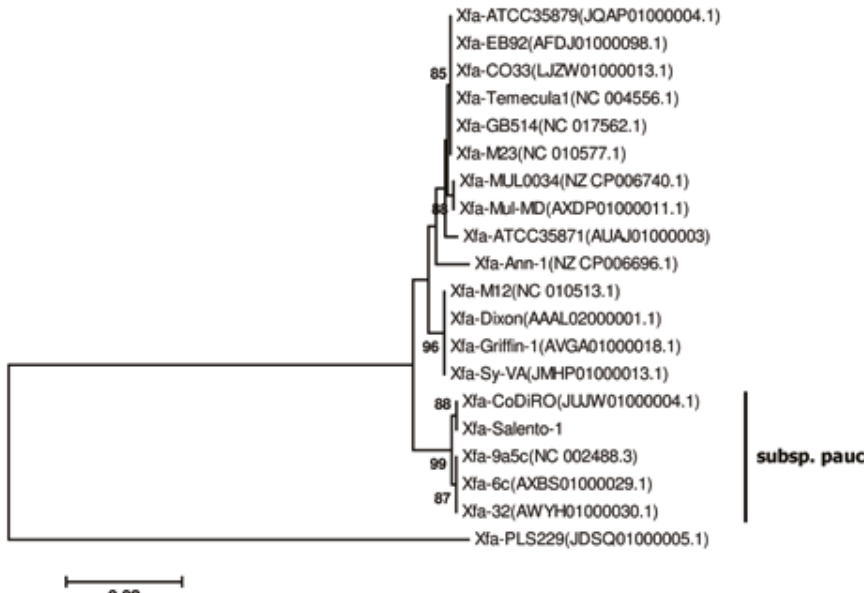
Figure 5. Neighbour joining dendrogram showing the similarity of 20 strains of Xylella fastidiosa based on rpoD partial sequence analysis (1308 nucleotides). Numbers above or below branches are bootstrap values based on 1000 pseudorepli- cates (only values above 80% are shown) under the Kimura 2 parameters model of evolution with gamma rate of variation across sites. The accession numbers of the reference strains genomes are given in